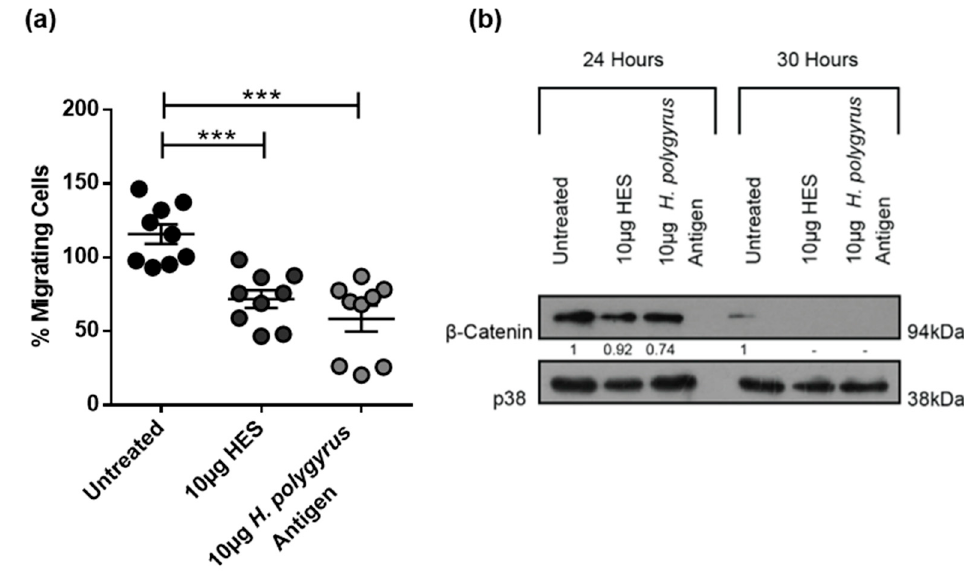
Figure 5. H. polygyrus -derived antigens decrease human colorectal cancer (CRC) cell migration and β -catenin expression. ( a ) Transwell migration assay of HCT116 cells determined at 24 h, following exposure to 10 μ g HES, 10 μ g H. polygyrus antigen, or an untreated control; ( b ) Western blot analysis of β -catenin and p38 (loading control) was performed 24- or 30-h following exposure of HCT116 cells to 10 μ g HES, 10 μ g H. polygyrus antigen, or an untreated control. Densitometry readings were obtained using ImageJ in order to determine the changes in protein expression of β -catenin normalized to p38 and expressed as a fold-change relative to control wells. The data is representative of three ( a ) and one ( b ) independent experiments. Significance was analyzed using GraphPad Prism 6.01 and a one-way ANOVA was performed, where * p < 0.05, * * p < 0.01, and ** * p < 0.001. Error bars represent the standard error of the mean.